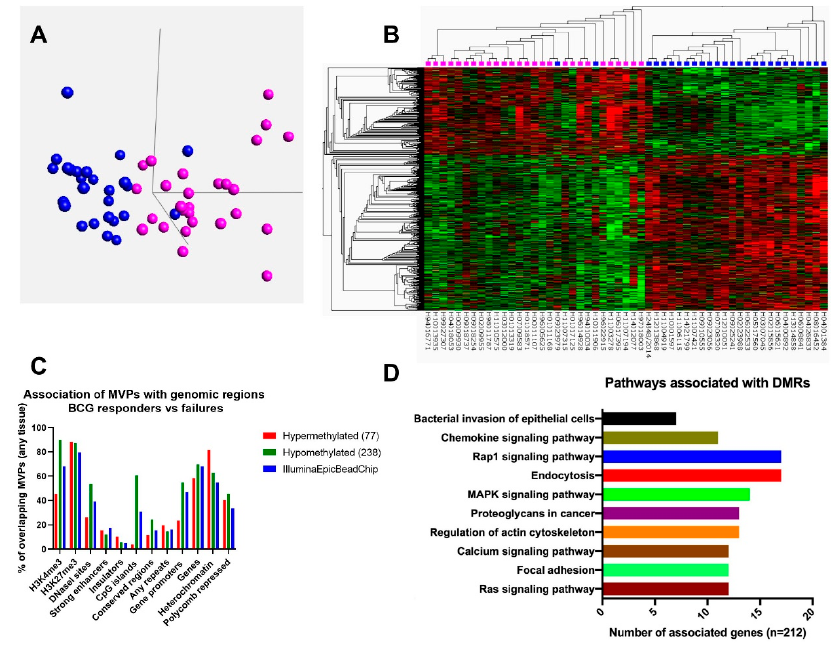
Figure 1. Distinct DNA methylation patterns between BCG responders and failures. ( A ) Principal component analysis of 26 BCG responders and 27 failures performed on the 15332 Methylation Variable Positions (MVPs) with a p -value of < 0.01 leads to grouping of the two cohorts. Sample annotation: Blue BCG responder, pink BCG failure. ( B ) Hierarchical clustering of top differentially methylated CpGs between BCG responders and failures (color corresponds to percentage of methylation, from red = 100% methylation to green = 0% methylation). Sample annotation: blue BCG responder, pink BCG failure. ( C ) EpiExplorer analysis using indicated genomic features of hypermethylated (red) and hypomethylated (green) methylation variable positions (MVPs) for BCG responders compared to BCG failures in relation to CpG sites on the Illumina array (blue). CpG sites of the Illumina array serve as control set. ( D ) Gene ontology (GO) term analysis of 694 genes harboring differentially methylated regions (DMRs) using the Database for Annotation, Visualization and Integrated Discovery (DAVID) and association with biological processes.